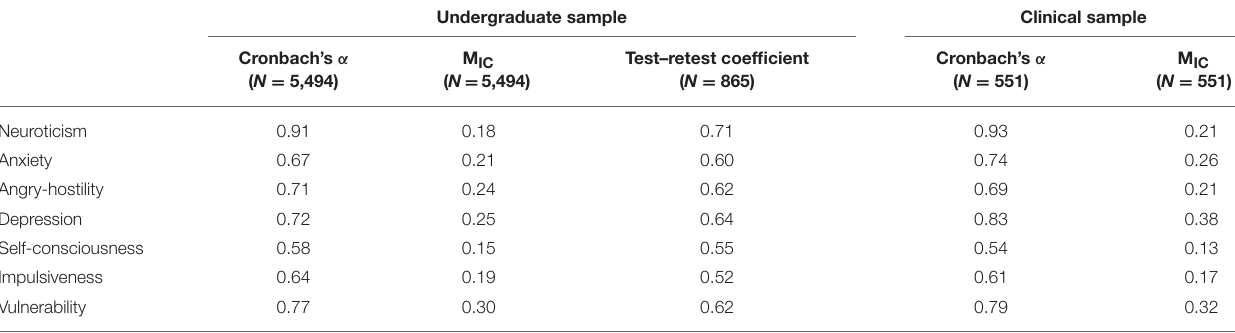
TABLE 4 | The Cronbach’s α , mean inter-item correlation and test-retest reliability for the neuroticism subscale and its six facets. Undergraduate sample